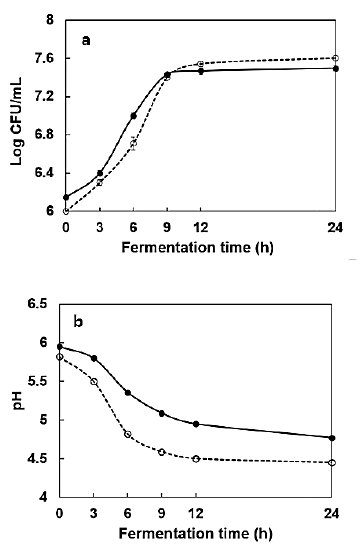
Figure 1. Growth curve ( a ) and pH ( b ) changes in hydroponic ginseng root and shoot during 24 h fermentation by Leuconostoc mesenteroides KCCM 12010P. Hydroponic ginseng (HPG) roots (●); HPG shoots ( ○